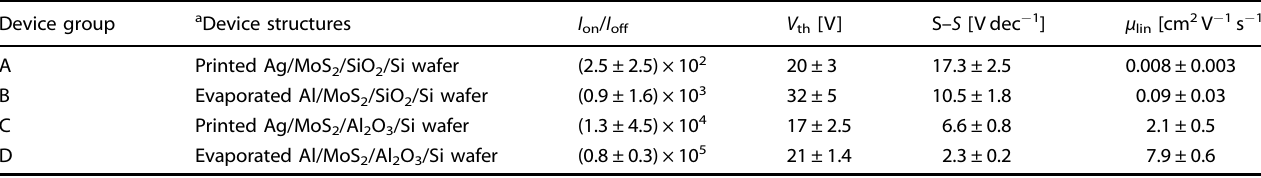
Table 1. Electrical properties of solution-processed MoS 2 TFTs with device con fi gurations. Device